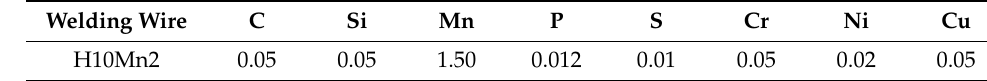
Figure 2. Picture of the welding equipment. Table 3. Chemical composition of the H10Mn2, wt.%.